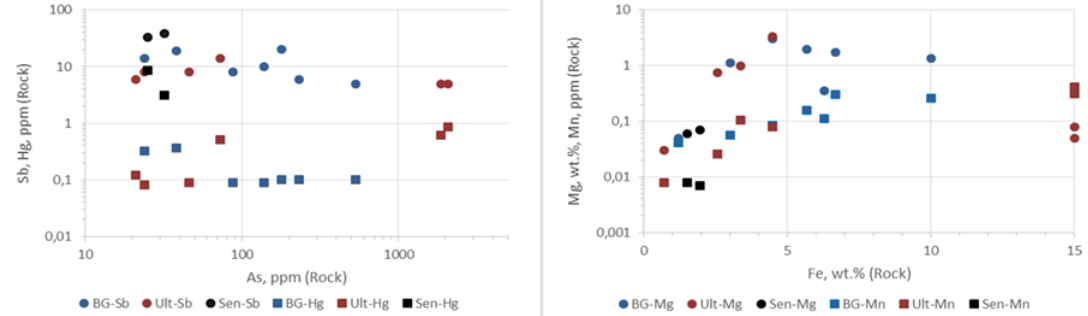
Figure 5. ( a) Concentrations of Sb, Hg vs. As and (b) Mg, Mn vs. Fe in rocks of the Uyanga orogenic gold